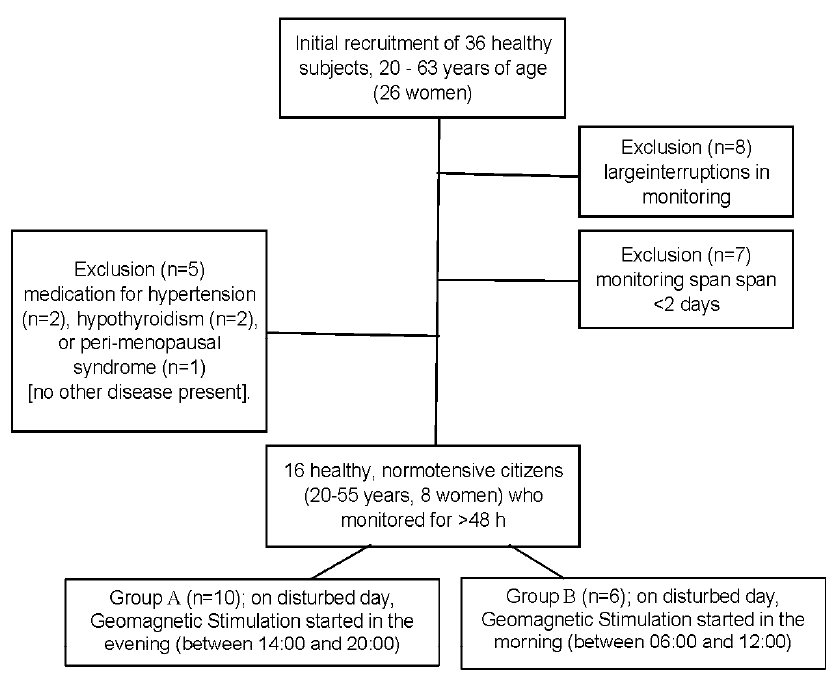
Figure 1. Consort